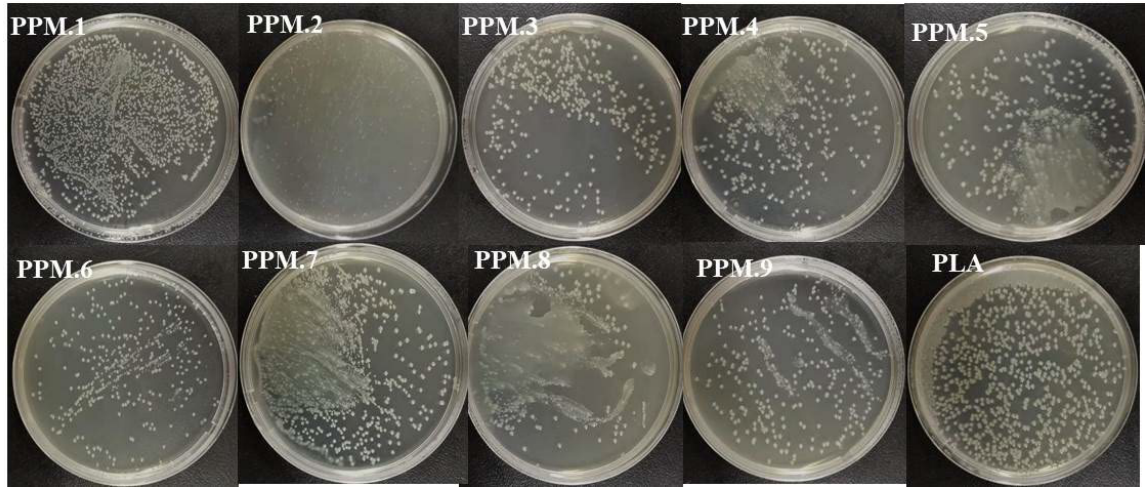
Figure 7. Antibacterial effect of antioxidant films containing assemblies of different amounts.